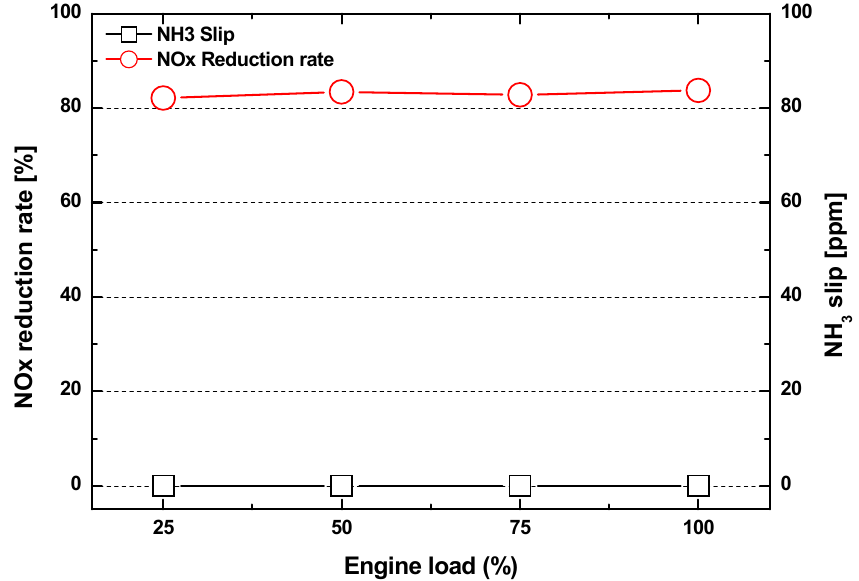
Figure 13. Characteristics of NOx reduction rate and NH 3 slip in relation to MCR conditions.